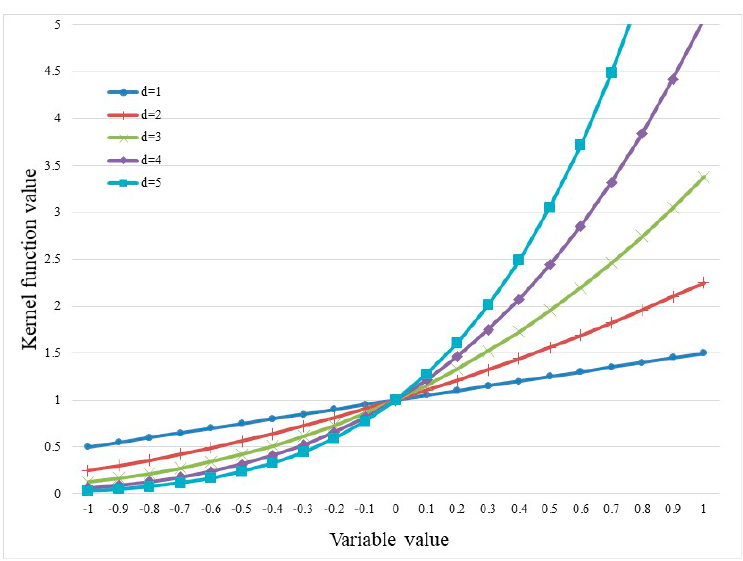
Figure 5. The data distribution characteristics of the Poly kernel function.